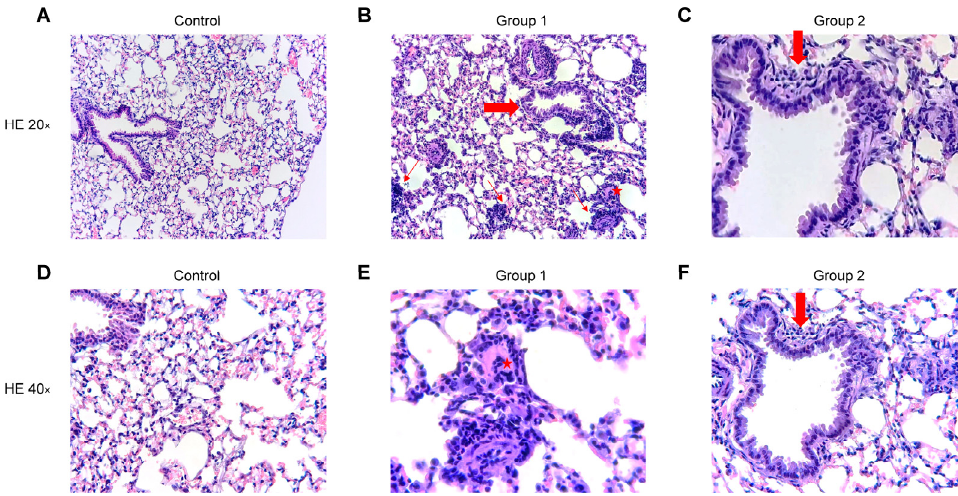
Figure 7. Representative images of haematoxylin and eosin (HE) stained histological lung sections. Experimental groups in this figure are represented with sections at 20× and 40× magnification from control group ( A , D ), Group 1 ( B , E ) and Group 2 ( C , F ). ( A , D ) Normal lung parenchyma. ( B ) Lung tissue with cellular bronchiolitis (big arrow), patchy interstitial pneumonitis (thin arrows) and giant cell (star). ( E ) Higher magnification of the giant cell (star). ( C , F ) Lung tissue with mild cellular bronchiolitis (big arrow).